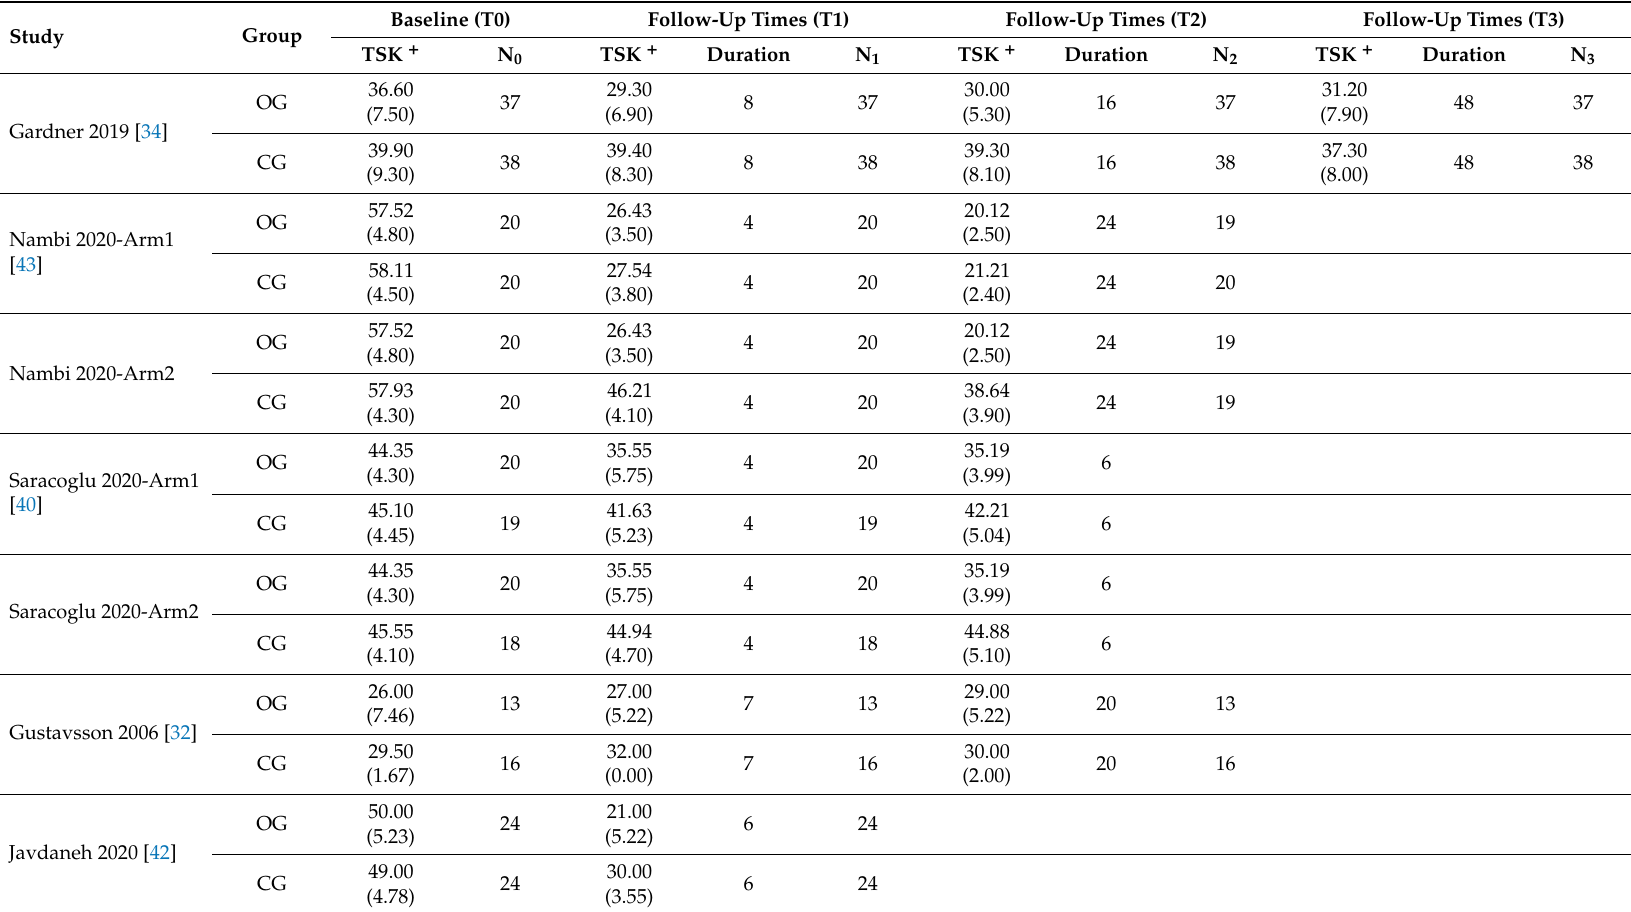
Table 2. The converted scores of TSK by the form of MEAN